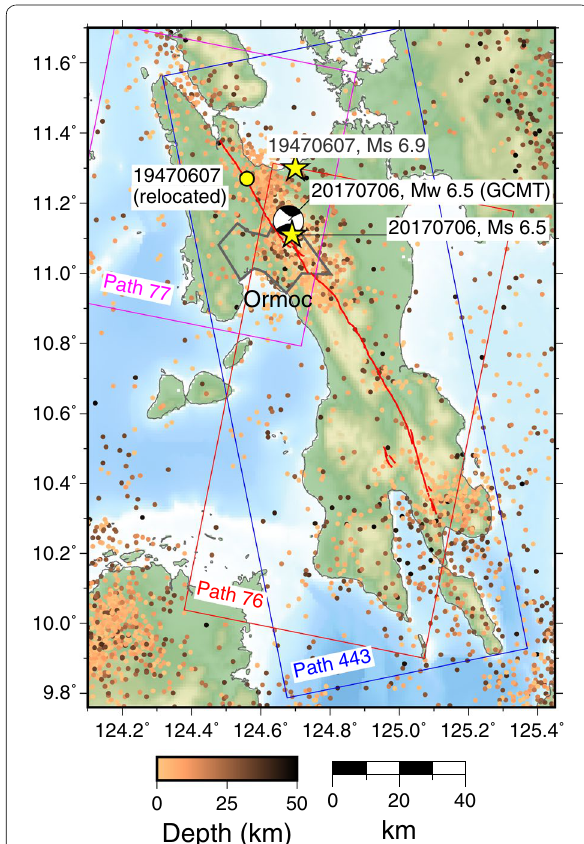
Fig. 2 Hypocenters of the 1947 and 2017 earthquakes from the PHIVOLCS catalog (yellow stars), hypocenter of the 1947 earthquake relocated by Lumbang and Hurukawa (2014) (yellow-filled circle), and GCMT solution for the 2017 earthquake. Plotted together are Philippine fault traces (red lines), seismicity of shallower than 50 km in 2000–2017 (PHIVOLCS catalog, color dots), and scene areas of PALSAR data used for the creep analysis